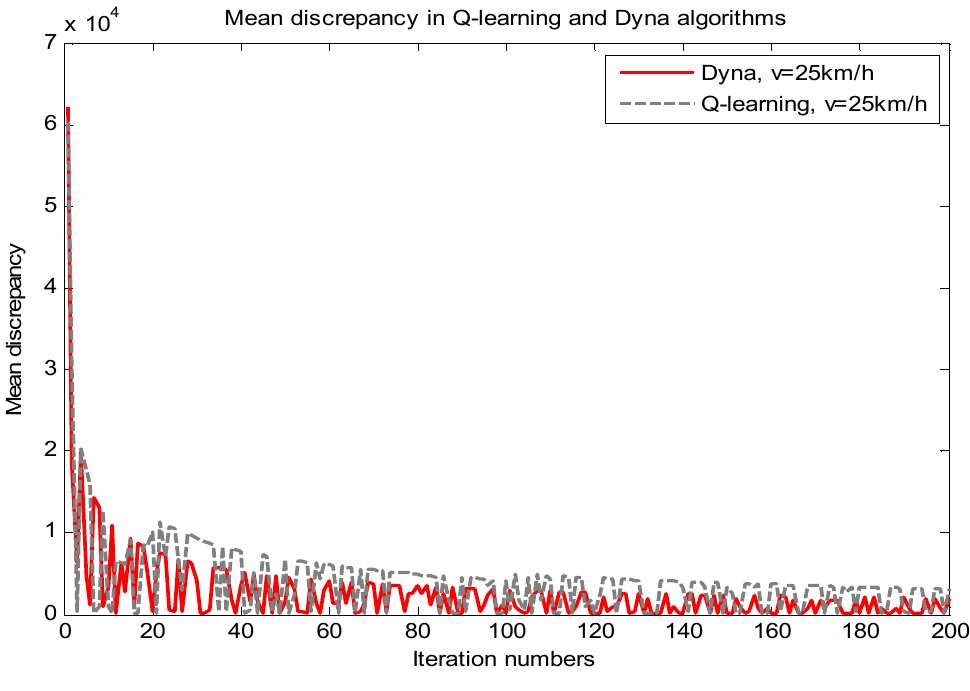
Figure 9. Experimental driving schedule used in the simulation.